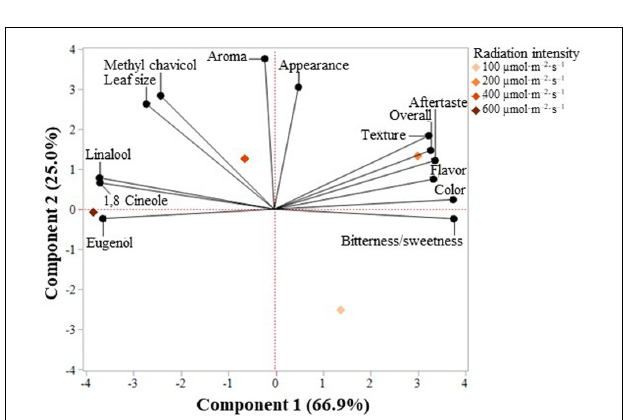
FIGURE 7 | Frequency heat map of words used to describe sweet basil “Nufar” ( Ocimum basilicum ) grown under radiation intensities of 100, 200, 400, or 600 µ mol · m − 2 · s − 1 photosynthetic photon flux density (PPFD). χ 2 describes the goodness of fit; phylogenetic trees depict the cluster analysis relationship between words used and the relationship between words used and samples. All words reported exhibited differences P < 0.05 based on 90 respondents.